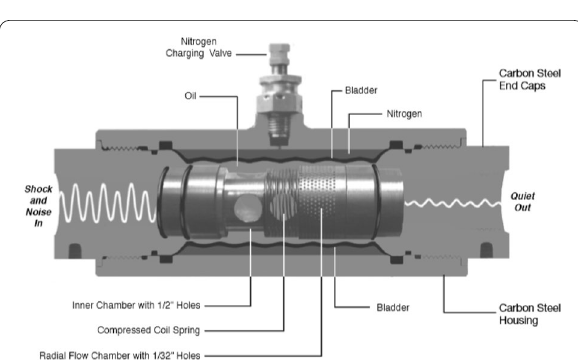
Figure 22 Pulse-Tone pulsation